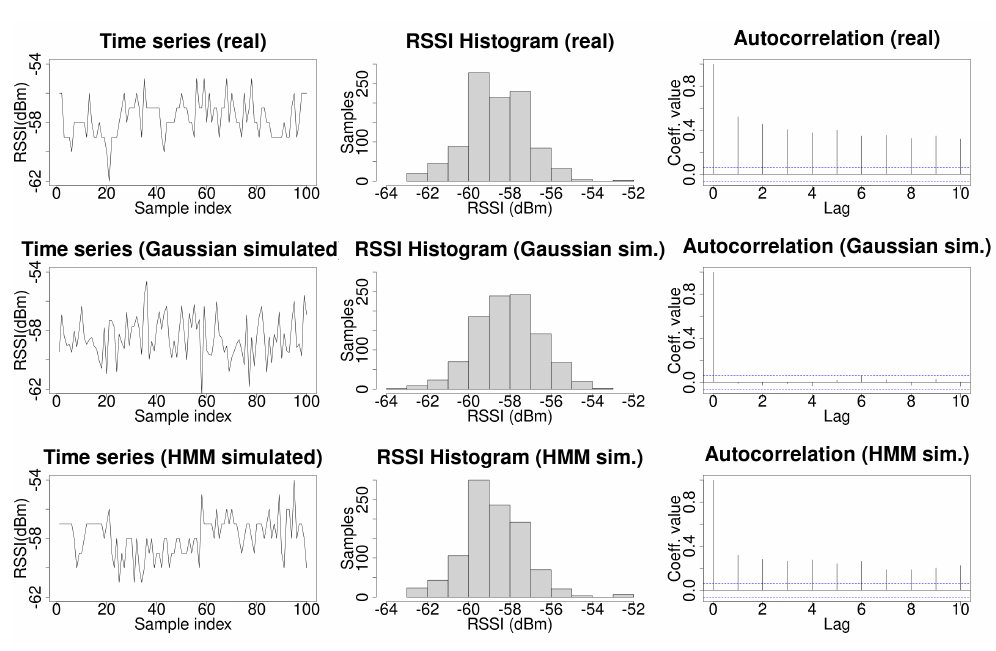
Figure 2. An example of an Received Signal Strength Indicator (RSSI) time series for a Wireless Access Point (WAP) ( left column), its histogram ( middle column), and its autocorrelation ( right column), with real data on the top row, Gaussian simulated data in the middle row, and HMM simulated data along the bottom